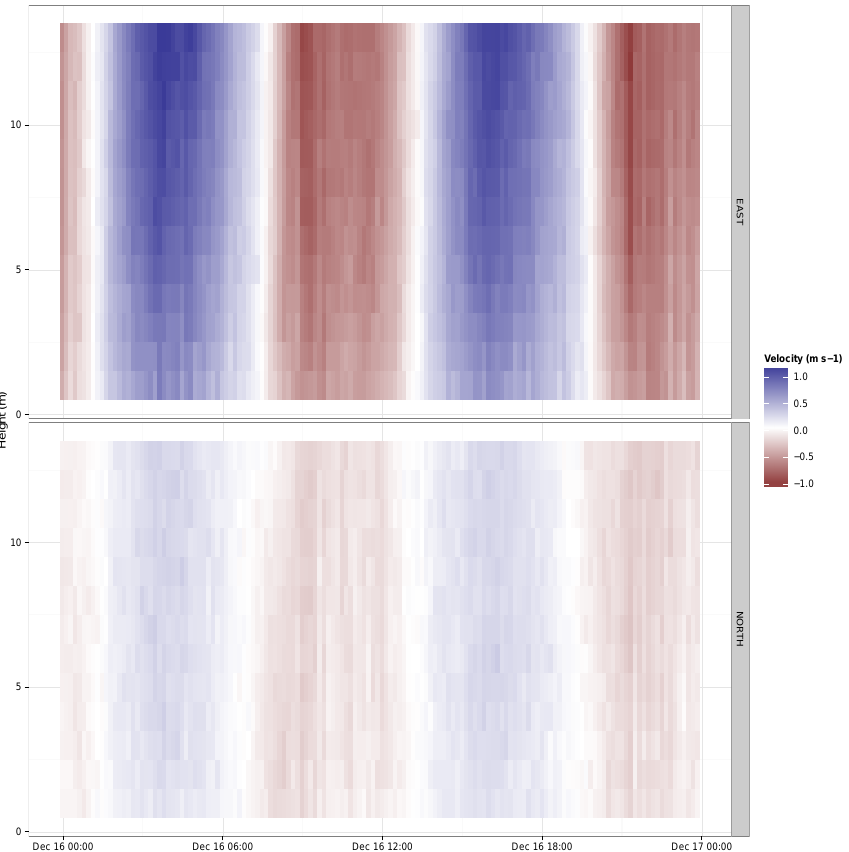
Figure A1. Acoustic Doppler current profiler data from the Warp SmartBuoy site showing the tidally dominated current regime. Top panel vectors for east, bottom panel for